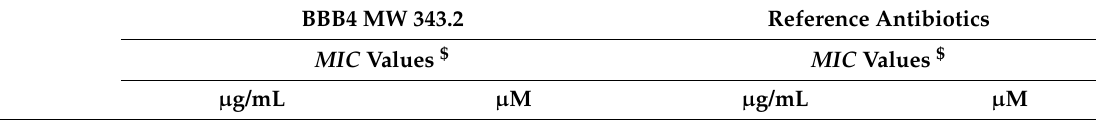
Table 2. MICs of BBB4 as µ g/mL and micromolarity ( µ M), against representative clinical isolates of Gram-positive and Gram-negative species, including several strains of the Staphylococcus genus. The reference strain S. aureus ATCC 29213 was also